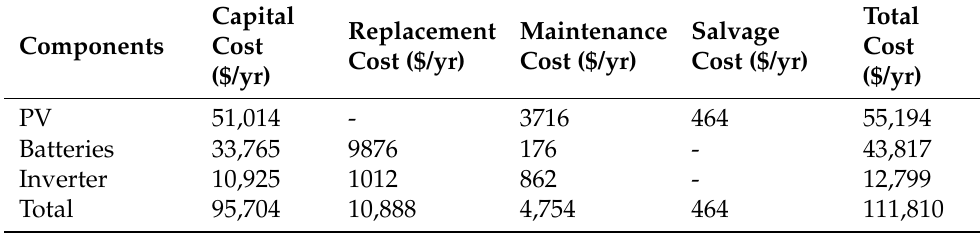
Table 6. ASC analysis and cost contribution of different components using MFABC+